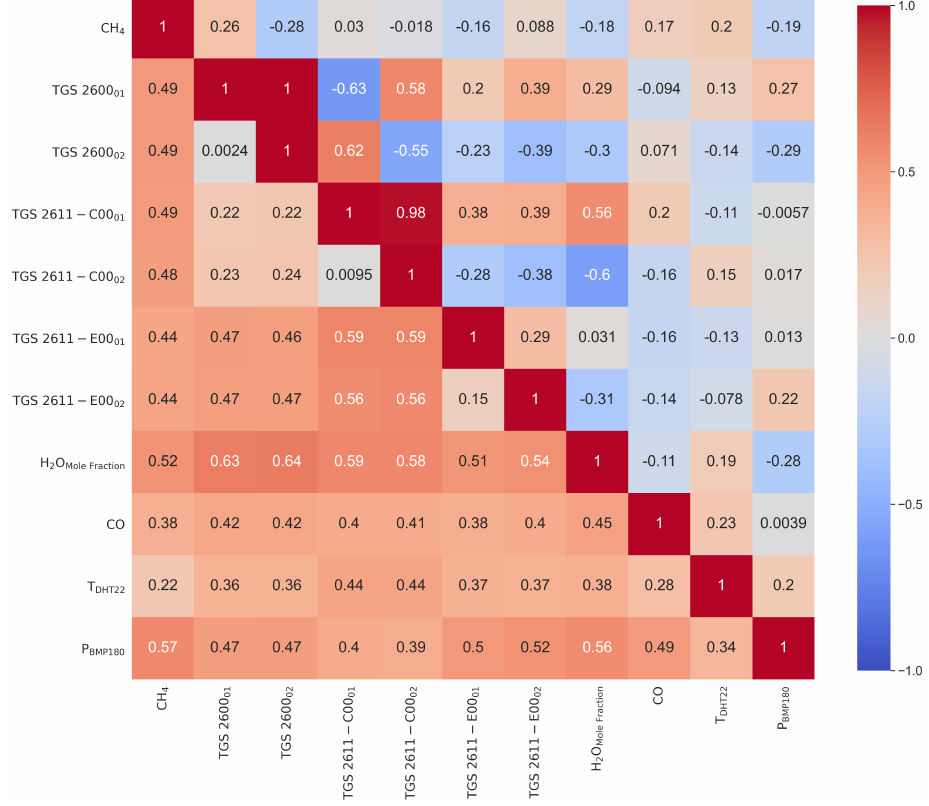
Figure A6. Partial correlation (r) matrix (upper triangular) and standard deviation of correlation for bins of 3 days previously smoothed at an hourly scale (lower